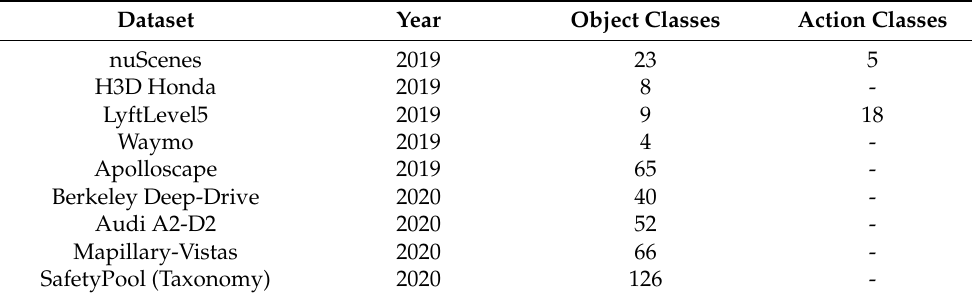
Table 1. Summary of the analyzed datasets for defining the taxonomy of the